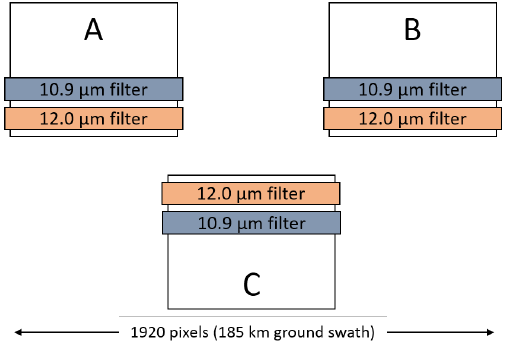
Figure 4. The Thermal Infrared Sensor (TIRS) focal plane array consists of three detector arrays (labeled A, B, and C) arranged to span the cross-track 185 km swath. Spectral filters over the arrays produce the two thermal bands (Bands 10 and